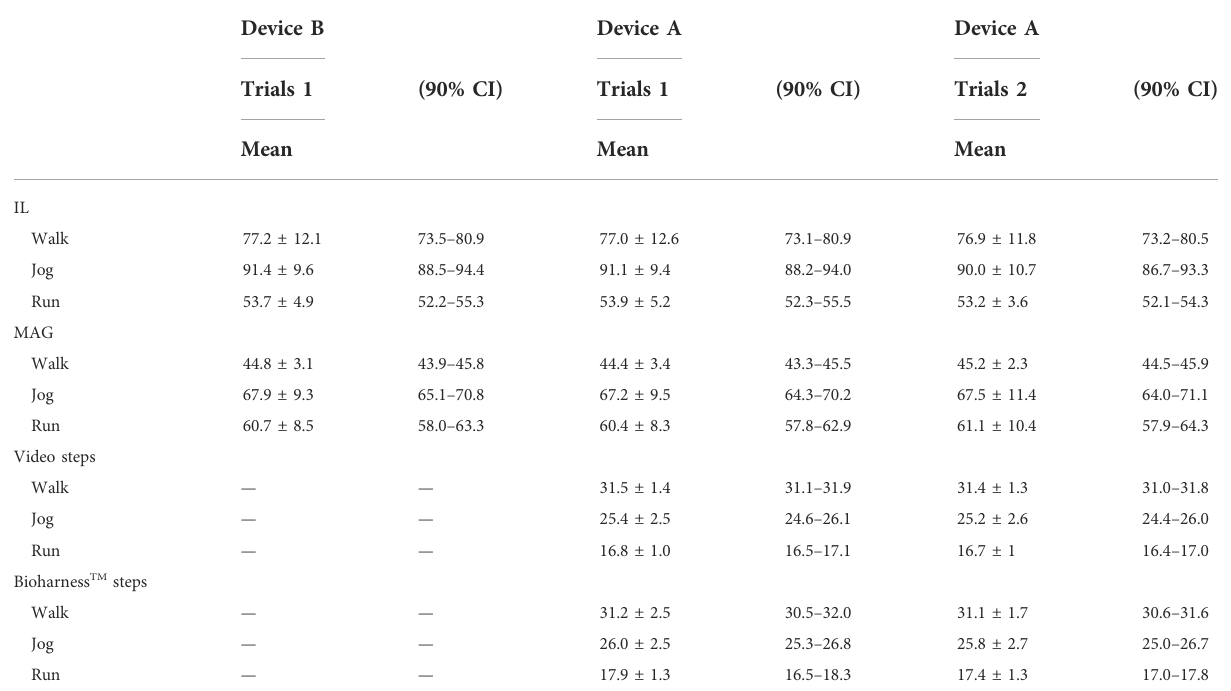
TABLE 2 Means and 90% CI for IL, MAG, and step counts for device A and B of trial 1 –